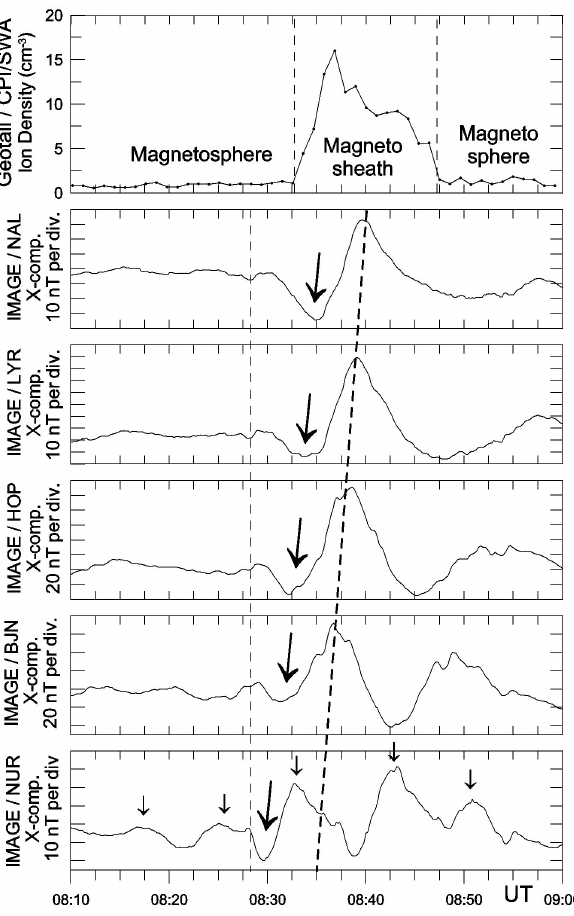
Fig. 9. Geotail for a short time period ( ∼ 12min) exits from the magnetosphere into magnetosheath and the CPI/SWA ion density increases. This exit is imposed by a solar wind pressure increase (not shown here), while the selected X-component magnetograms from the IMAGE stations show dispersive character in signature ar- rival